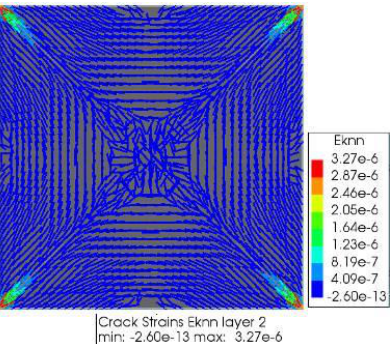
Figure 16. Crack strains distribution from nonlinear analysis, results are referred to the medium surface of the model with roller